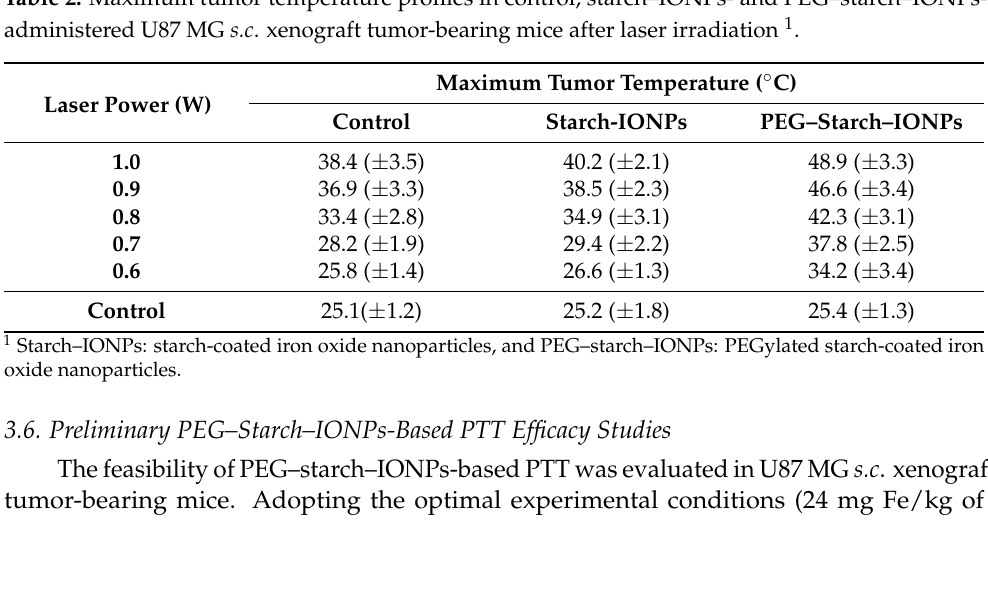
Figure 9. In vivo PTT effects of PEG–starch–IONPs in U87 MG s.c. tumor-bearing mice. Representative infrared (IR) images of the mice (N = 3) administered with either ( A ) PBS, ( B ) starch–IONPs, or ( C ) PEG–starch–IONPs during laser irradiation. When the average tumor size reached 200 mm 3 , starch–IONPs or PEG–starch–IONPs were separately administered to mice (N = 3) by intravenous injection (24 mg Fe/mL) and then laser (885 nm) was irradiated for 10 min at varying powers (0.6–1.0 W). The tumor temperature was monitored using an IR camera (E5, FLIR Systems). From the photo images, at 0.9 W the maximum tumor temperatures of the starch–IONPs and PEG–starch–IONPs-administered mice were 38.6 and 46.8 °C, respectively. ( D ) Tumor accumulation profiles of starch–IONPs vs. PEG–starch–IONPs (N = 5). The statistically significant differences in the tumor accumulation profiles were compared by Student’s t -test. *** p < 0.001. Table 2. Maximum tumor temperature profiles in control, starch–IONPs- and